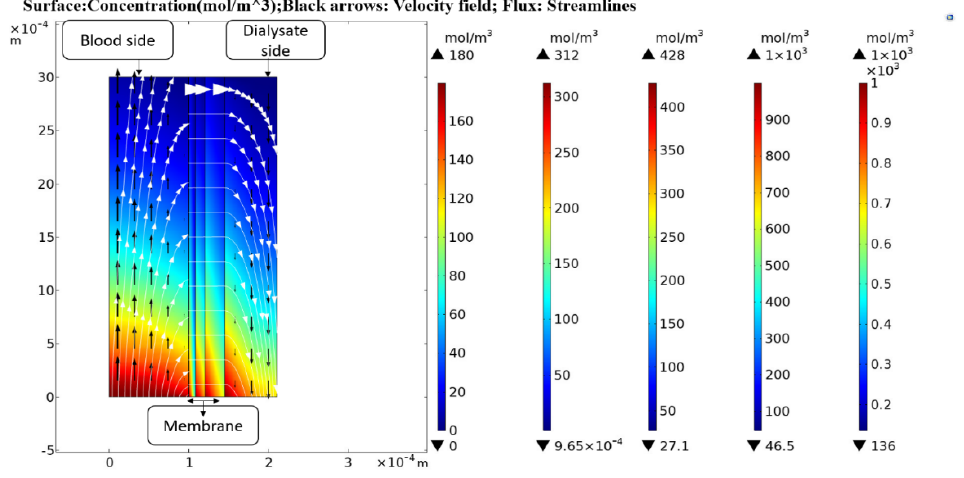
Figure 3. Axisymmetric concentration contour of urea at both blood and dialysate side and across the membrane.